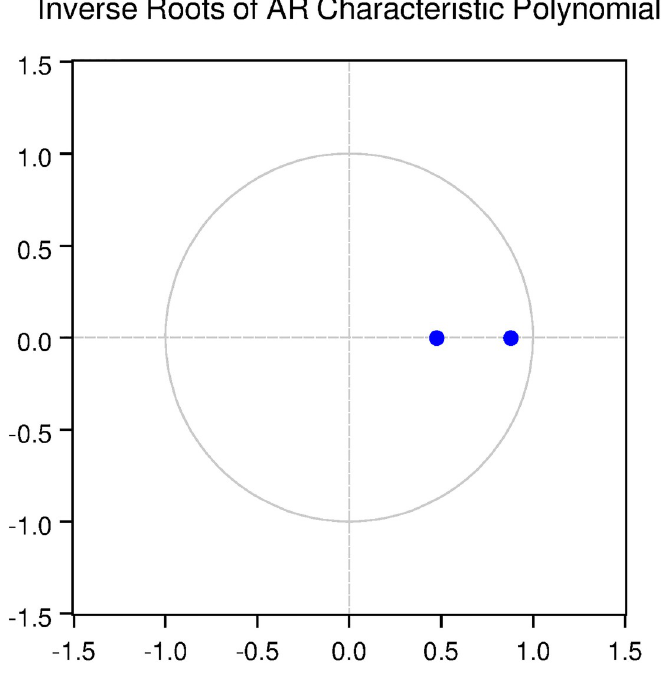
Fig 13. Inverse roots of AR characteristic polynomial for Swiss data when P = 1 (Fisherian model).